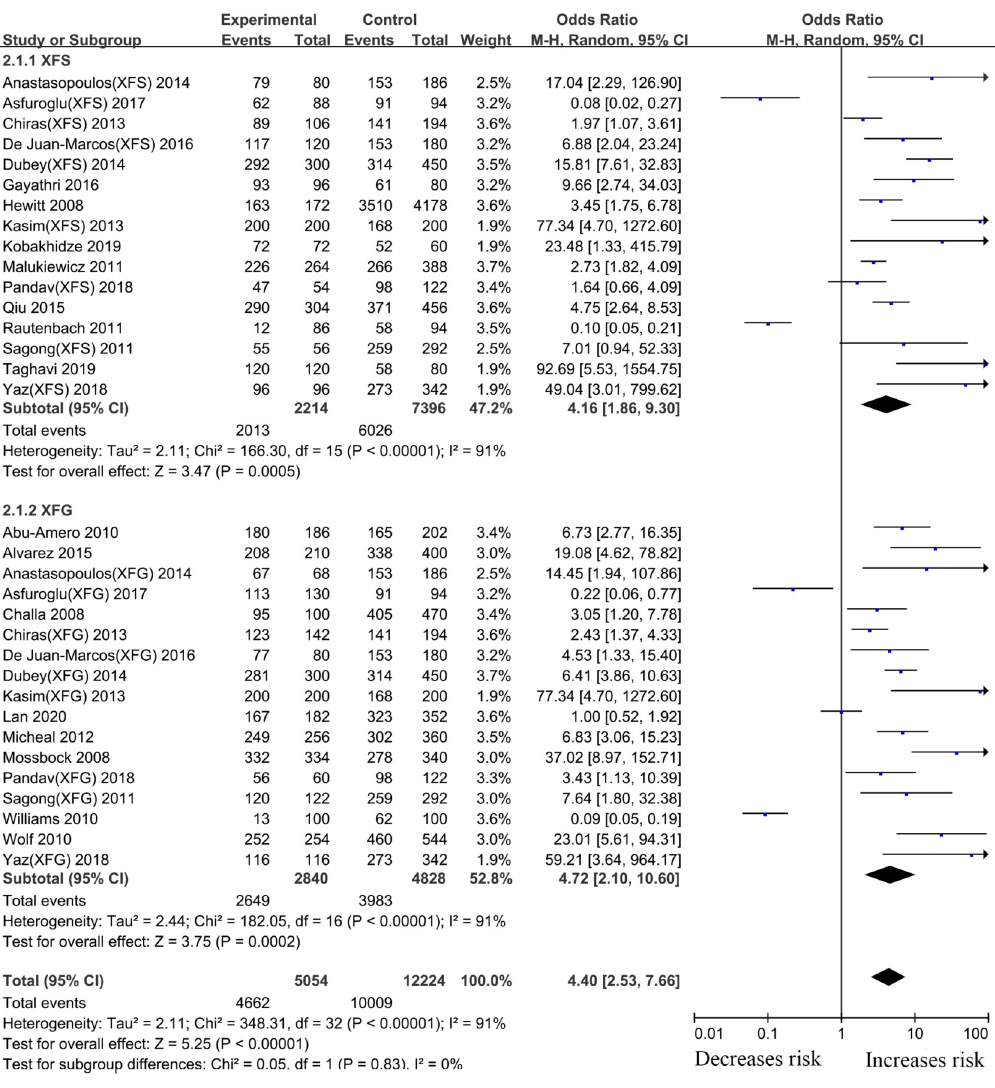
Fig 6. Meta-analysis for the association between exfoliation syndrome/exfoliation glaucoma risks and LOXL1 gene polymorphism rs3825942 (G vs. A): Subgroup analysis by disease types (squares depict individual studies and diamonds depict summary effect size estimates (Odds Ratio,